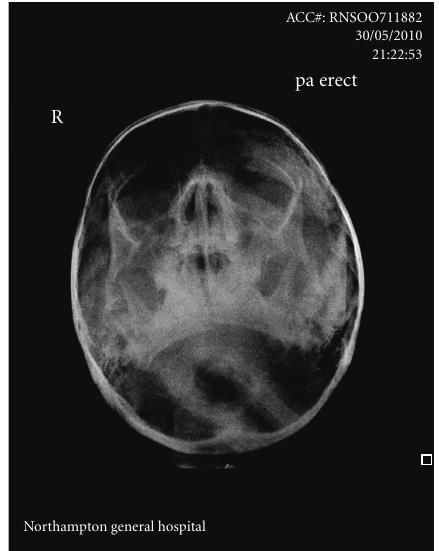
Figure 1: Postero-anterior view revealing a displaced fracture to the mandibular